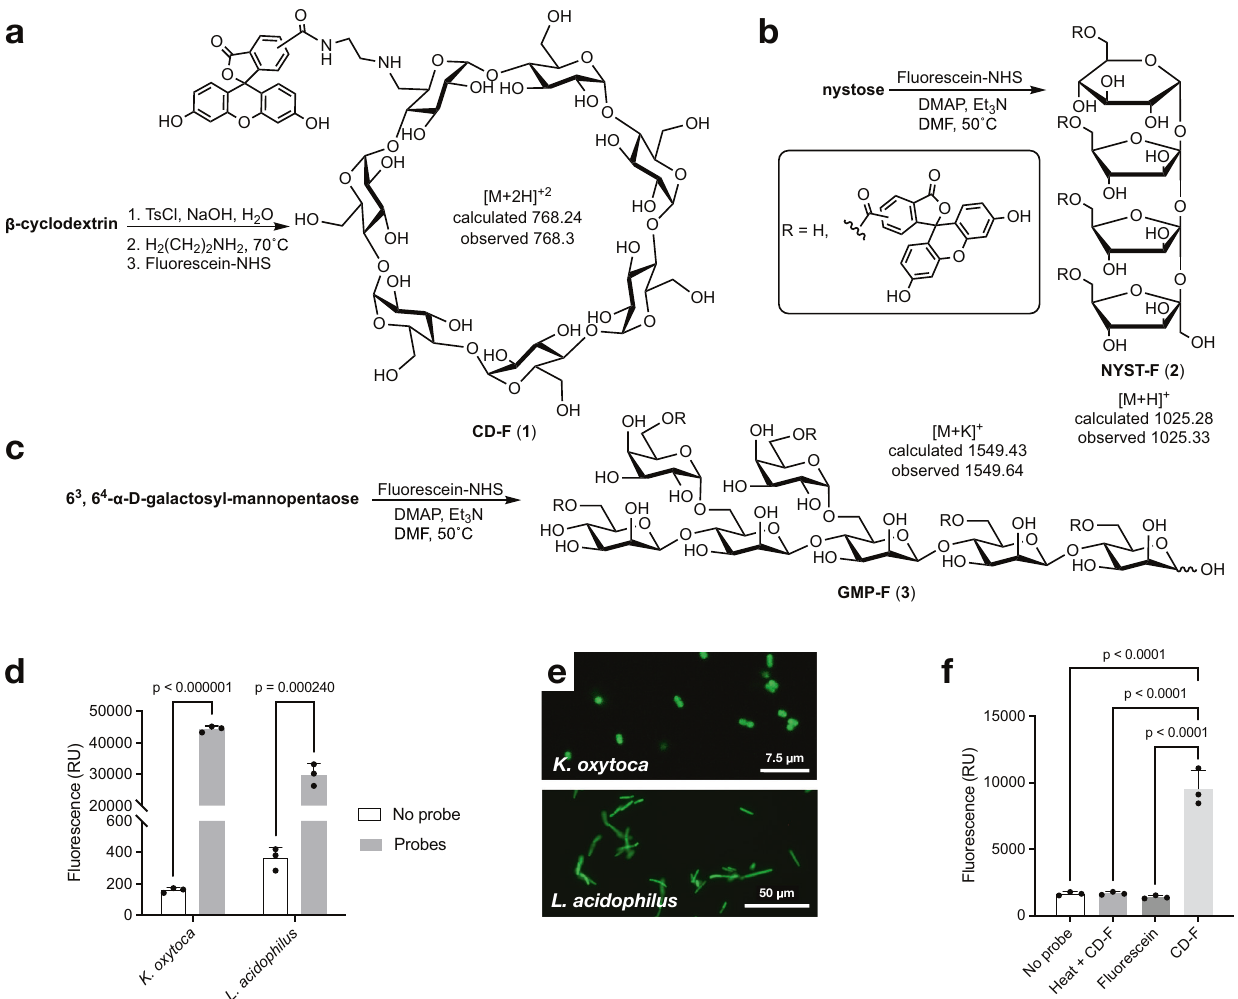
Fig. 1 | Cultured isolates are metabolically labeled by fl uorescent oligo- saccharides. a – c Synthesis of fl uorescent β -cyclodextrin ( a ), nystose ( b ), and galactosyl-mannopentaose ( c ) probes. Mono-functionalized glycans were puri fi ed by reverse-phase chromatography, size-exclusion chromatography, or high- performance liquid chromatography (HPLC). The products were characterized by mass spectrometry. d Fluorescence measured from washed K. oxytoca (Proteo- bacteria) and L. acidophilus (Firmicutes) cultures after incubation in their respec- tive minimum media with CD-F or NYST-F probe for 30min, as measured on a spectro fl uorometer. Data are the mean±SD ( n =3). Statistical signi fi cance com- paredtothe controlcondition byunpairedt-testswith Bonferroni-Dunn ’ smultiple